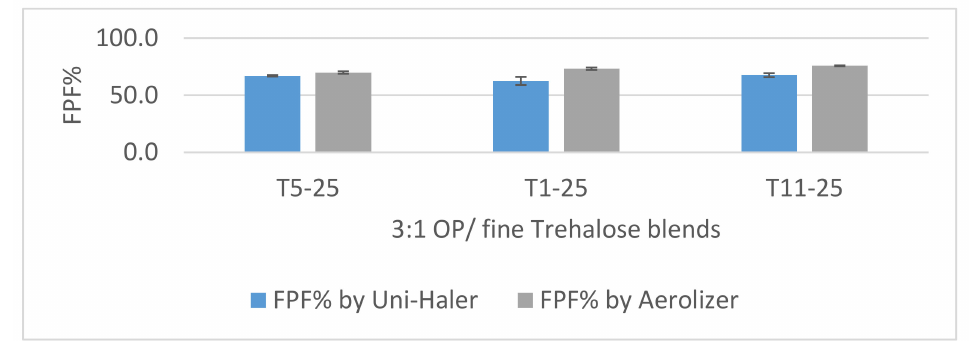
Figure 9. FPF% chart of 3:1 OP / fine trehalose blends using the Uni-Haler (blue bar) and Aerolizer (grey bar). Blends are arranged according to the trehalose grade from left (T5) largest, (T1) intermediate, and (T11) finest. Error bars based on calculated standard deviation from mean ( n =